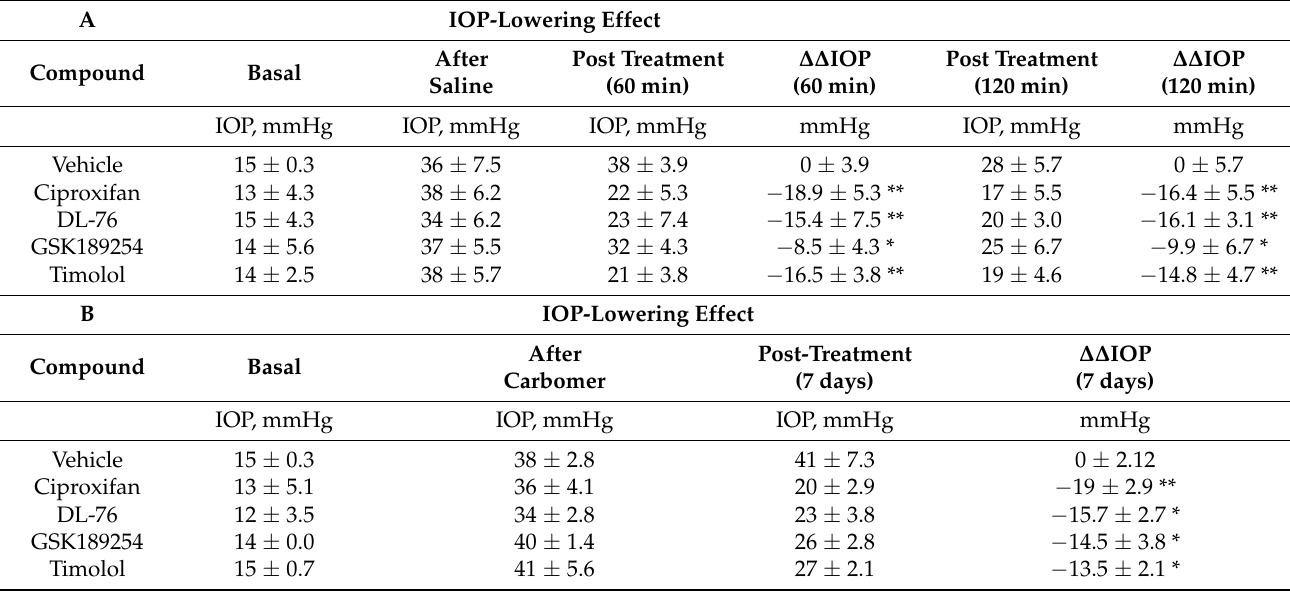
at a 1% dose, the gold standard treatment, is also reported (Table 1B).